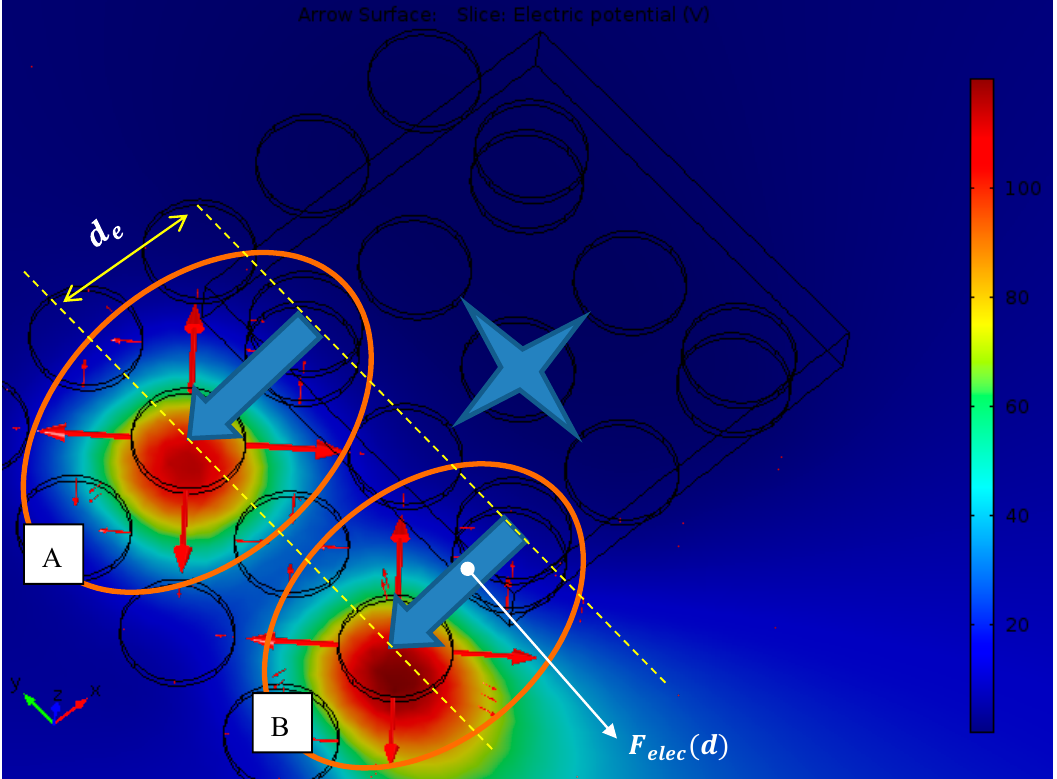
Figure 5. Snapshot of the simulated “Smart Platform” isolating the interactions between the platform and micropart electrodes.